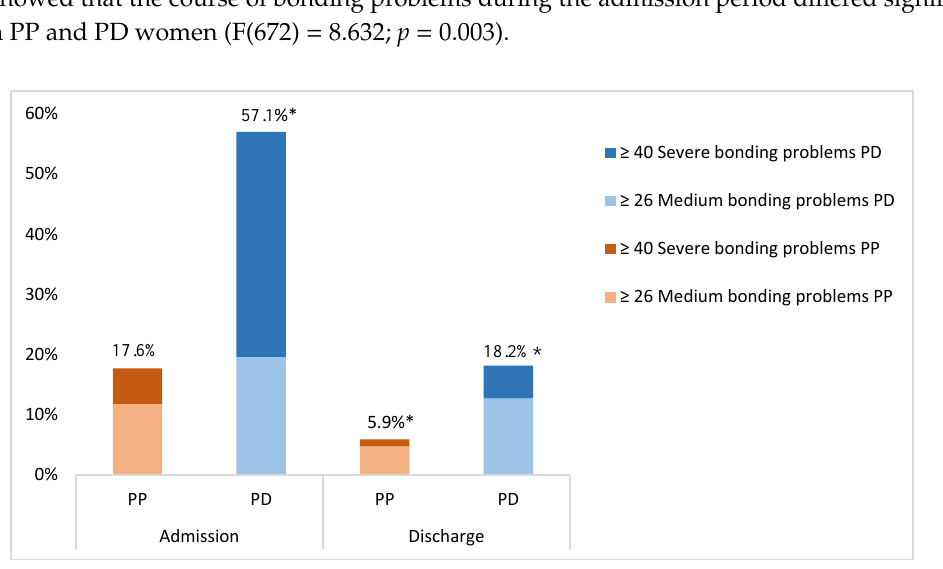
Figure 1. Proportion of women with PP and PD presenting with medium to severe impaired bonding at hospital admission and discharge; * = Significant result ( p < 0.05); Abbreviations: PP = postpartum psychosis; PD = postpartum depression; Note: PBQ scores were missing at random at both